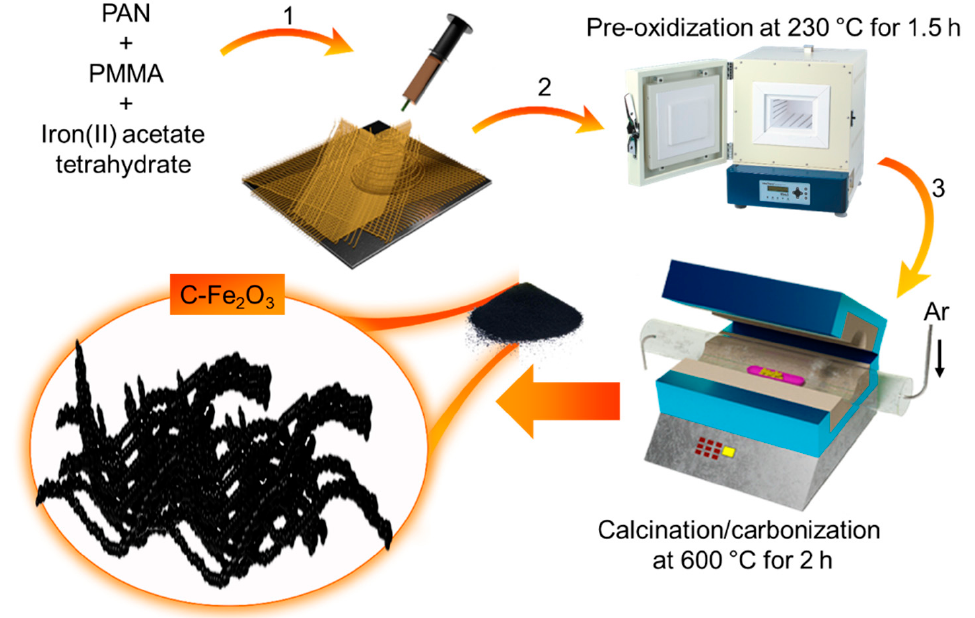
Scheme 1. Synthesis of C-Fe 2 O 3 active material by: (1) electrospinning of PAN/PMMA/C 4 H 14 FeO 8 solution in DMF followed by; (2) pre-oxidation; and (3) calcination/carbonization steps.